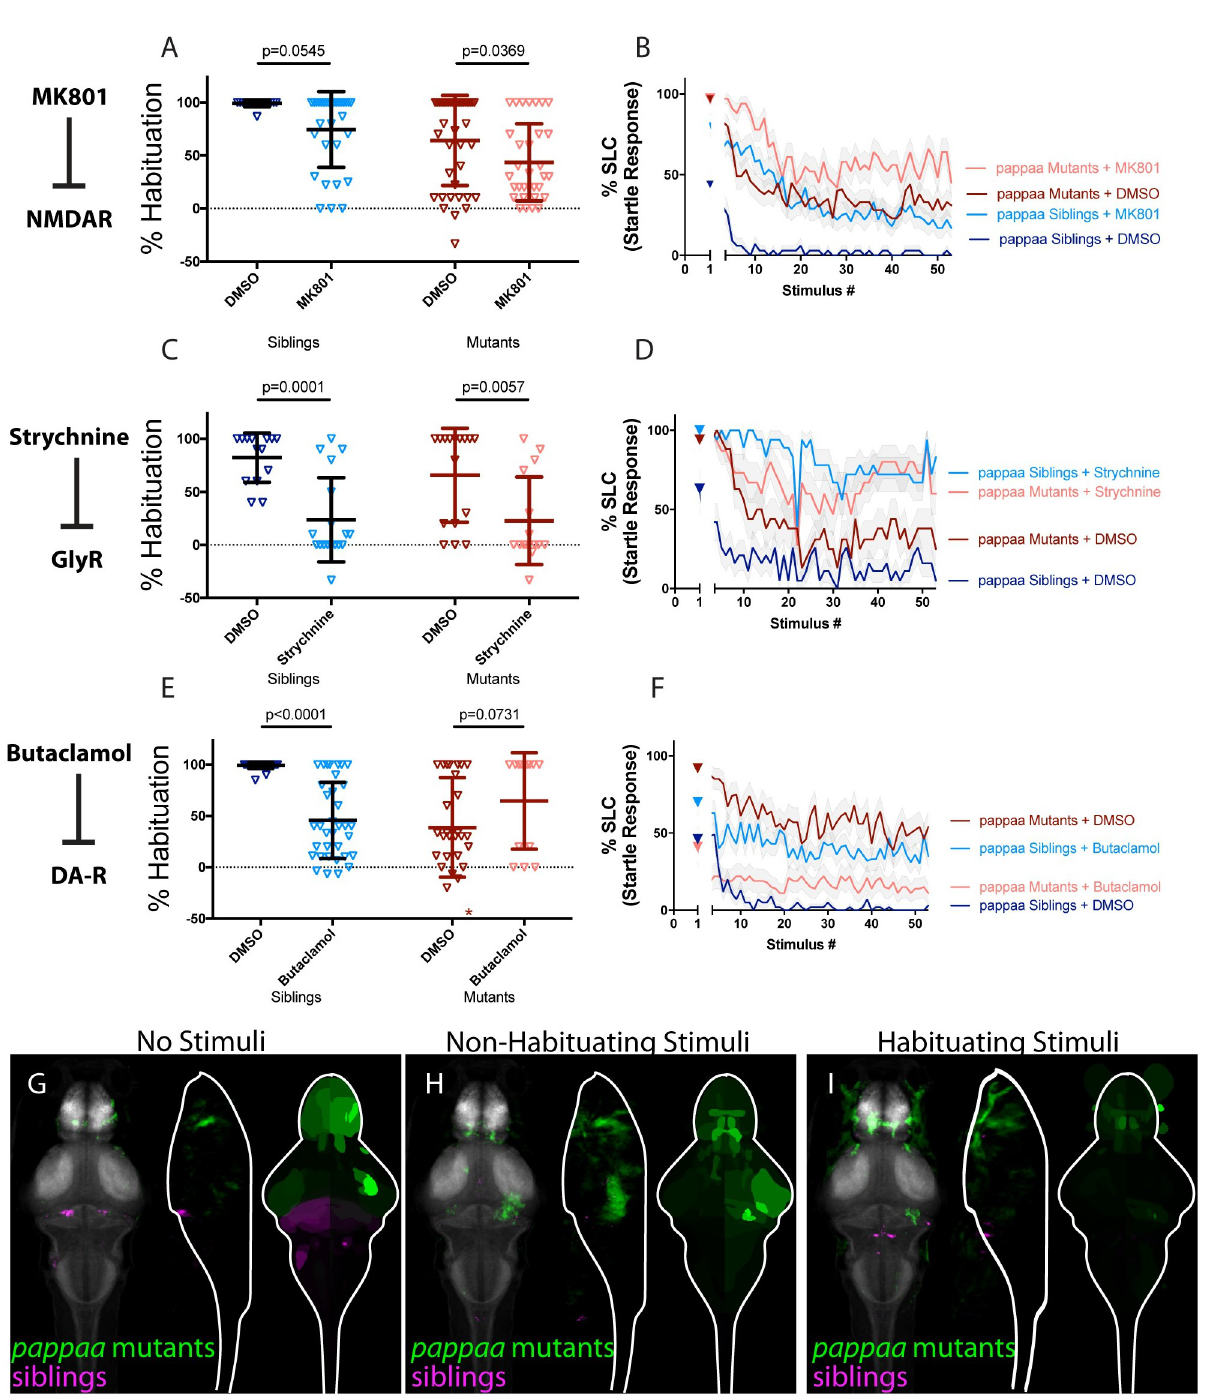
Fig 4. PAPP-AA promotes habituation by limiting endogenous dopamine signaling. (A-B) MK-801 significantly enhances habituation learning deficits observed in pappaa mutant larvae, indicating that NMDA signaling and pappaa may act within parallel molecular or circuit pathways to regulate habituation learning (p = 0.0369, n = 39 DMSO-mutants, n = 32 MK-801 mutants; p = 0.0545, n = 16 DMSO-siblings, n = 31 MK-801 siblings; p = 0.7637 indicates non-significant interaction between drug treatment and genotype). (C-D) Strychnine significantly enhances habituation learning deficits observed in pappaa mutant larvae, indicating that glycine signaling and pappaa may act within parallel molecular or circuit pathways to regulate habituation learning (p = 0.0057, n = 16 DMSO-mutants, n = 15 Strychnine-mutants; p = 0.0001, n = 14 DMSO-Siblings, n = 18 Strychnine-siblings; p = 0.4286 indicates non-significant interaction between drug treatment and genotype). (E-F) Butaclamol does not significantly enhance habituation learning deficits observed in pappaa mutant larvae, but rather trends toward significantly restoring habituation learning (p < 0.0001, n = 31 DMSO-